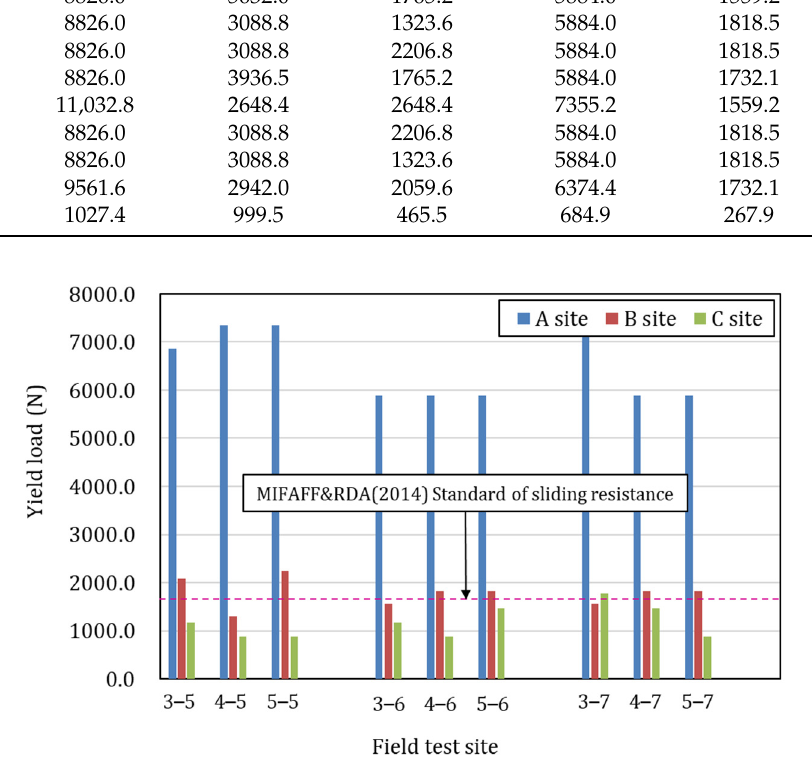
Figure 15. C omparison of field dry unit weight and MIFAFF and RDA standard. Figure 15. Comparison of field dry unit weight and MIFAFF and RDA